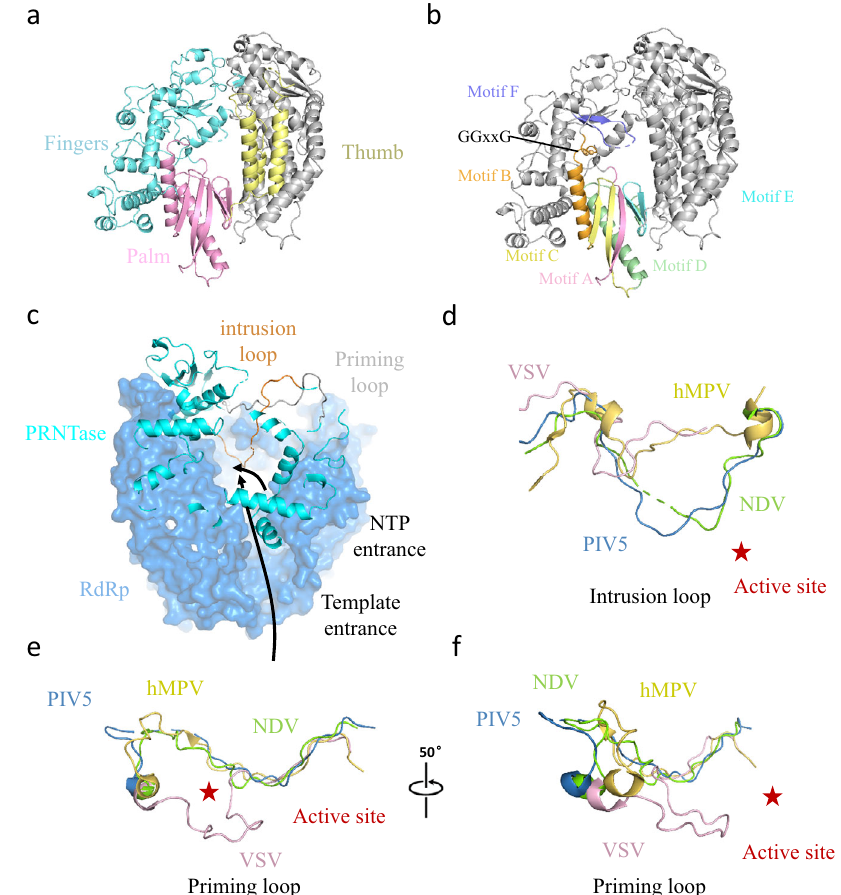
Fig. 3 | The active site of NDV L-P complex. a The RdRp region is highlighted in colors: the fi nger isshown in cyan, the thumb in pale yellow, the palm in light pink andtheremainingstructureofLiscoloredingray. b Similarviewasshownin a ,and motifs A – F are highlighted in unique colors. c Con fi guration of the priming loop (gray)andintrusionloop(brightorange)inNDVL-Pcomplex. d